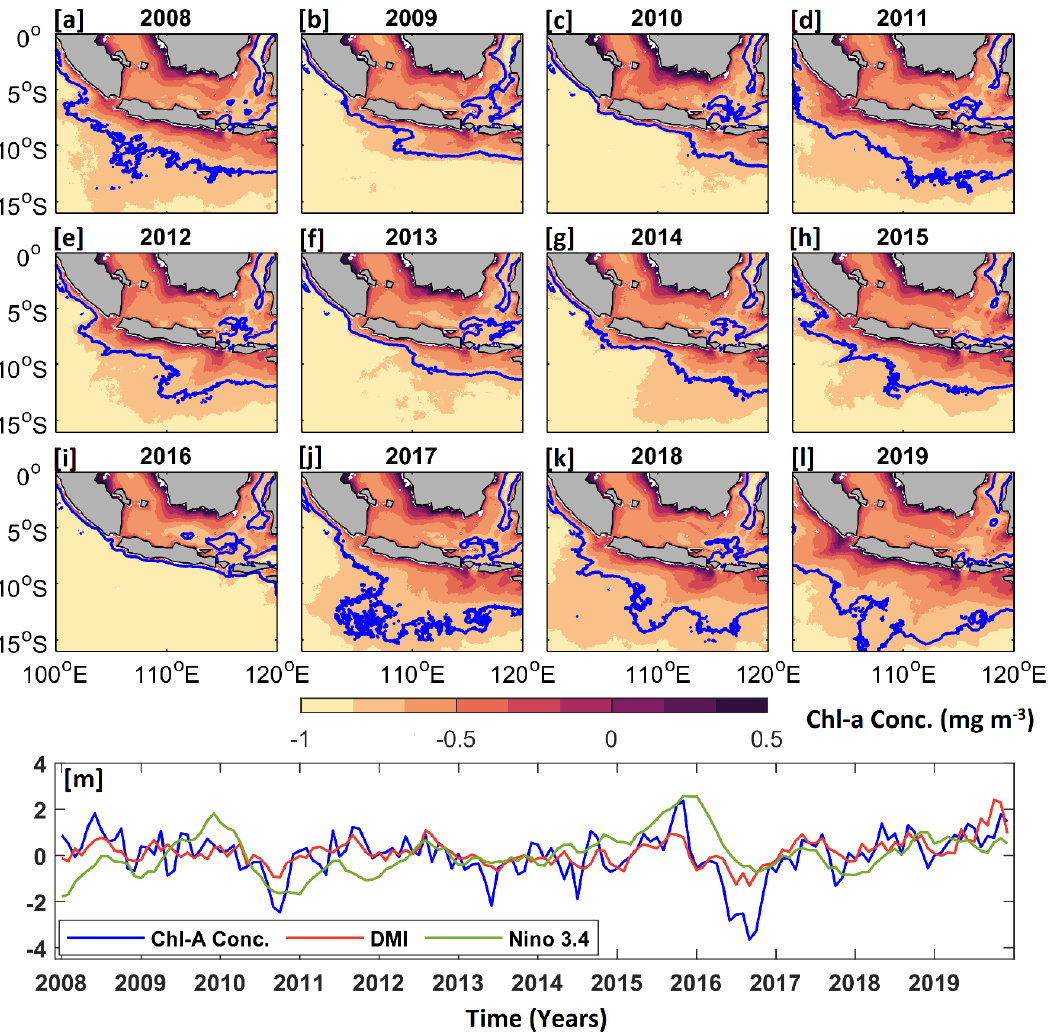
Figure 6. ( a − l ) The spatial distribution of chlorophyll-a concentration maps averaged during June – October every year from 2008–2019. The blue contours indicate the chlorophyll-a concentration ( − 0.8 mg m −3 on the logarithm scale). ( m ) Time series of Nino 3.4 index, Indian Ocean Dipole mode index (DMI) and region-averaged, detrended and normalized monthly chlorophyll-a concentration during 2008−2019 along the south Java coast.